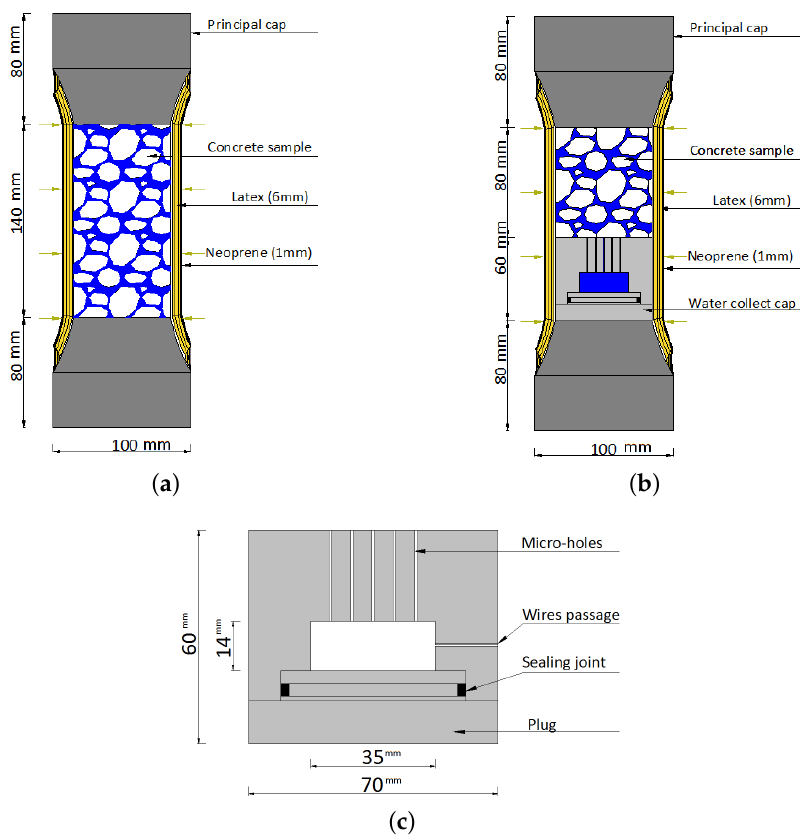
Figure 2. Water collecting cap concept: ( a ) initial configuration; ( b ) modified configuration with drainage system, shortened specimen and protection membranes; and ( c ) drainage cap design with micro-holes, plug and sealing